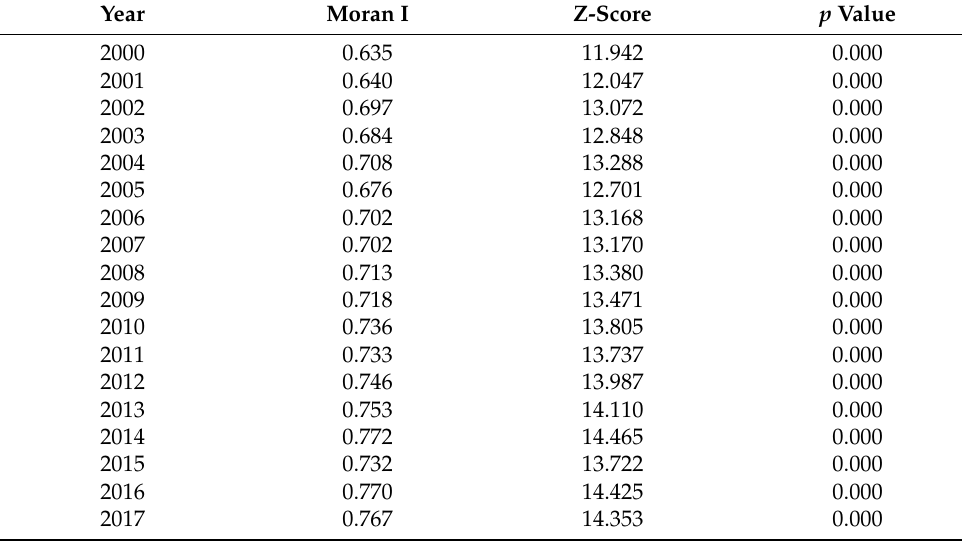
Table 2. Moran’s I test